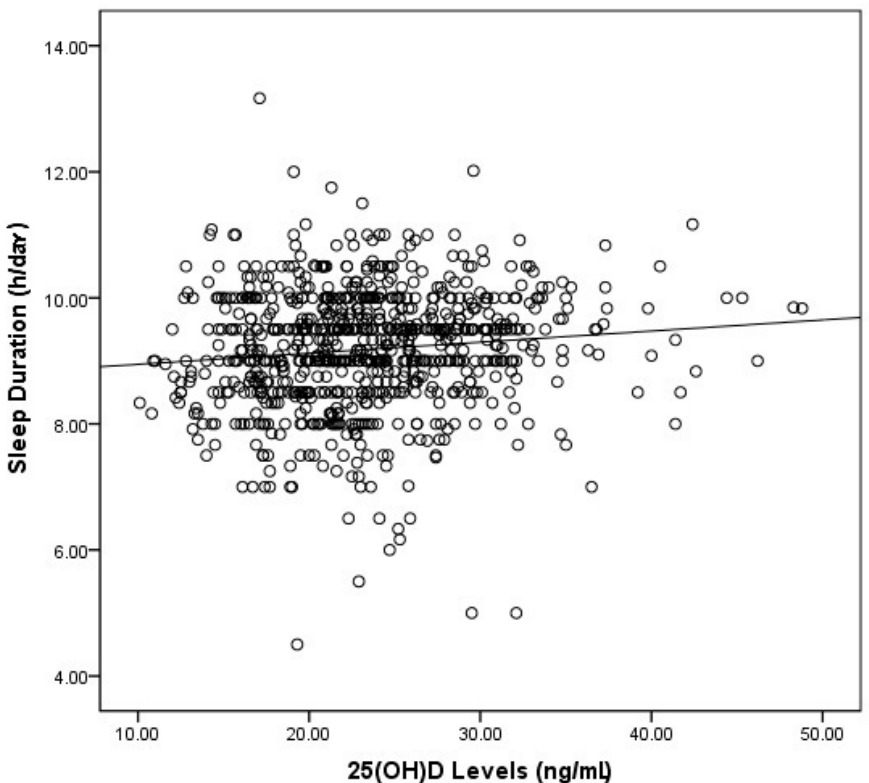
Figure 1. Correlation between sleep duration and 25(OH)D level in 800 subjects ( r = 0.11; p < 0.05).